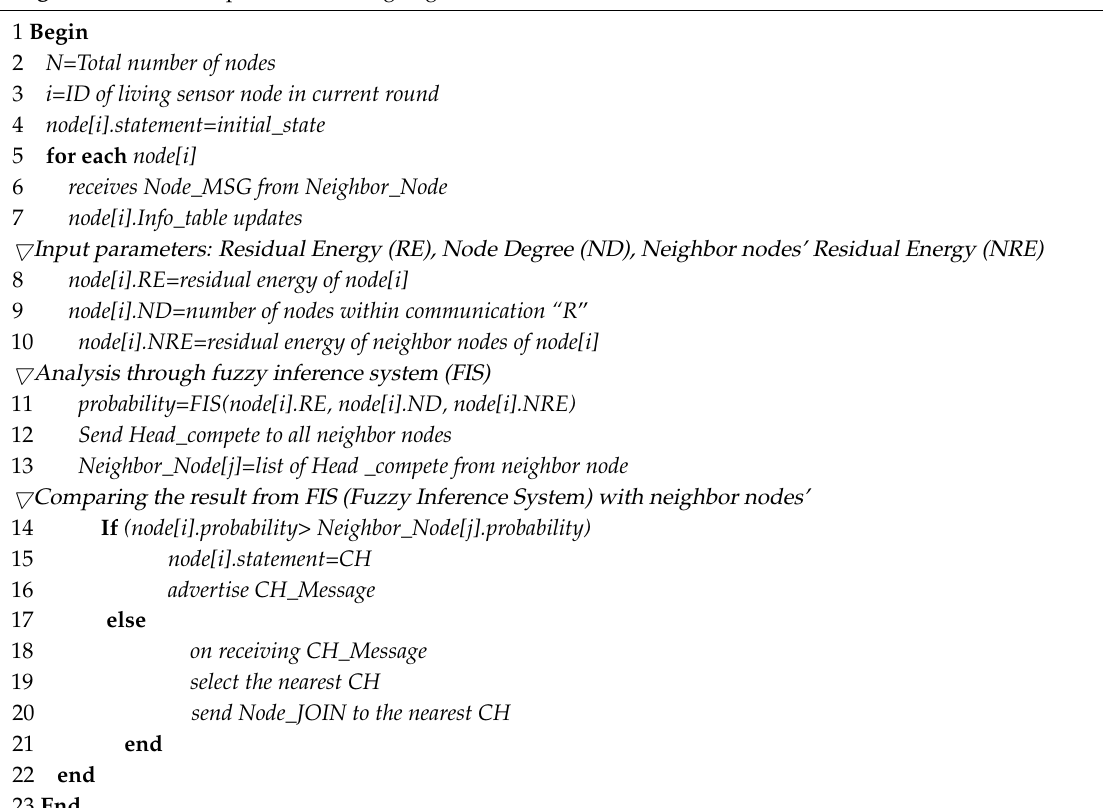
Algorithm 1. The Proposed Clustering Algorithm for